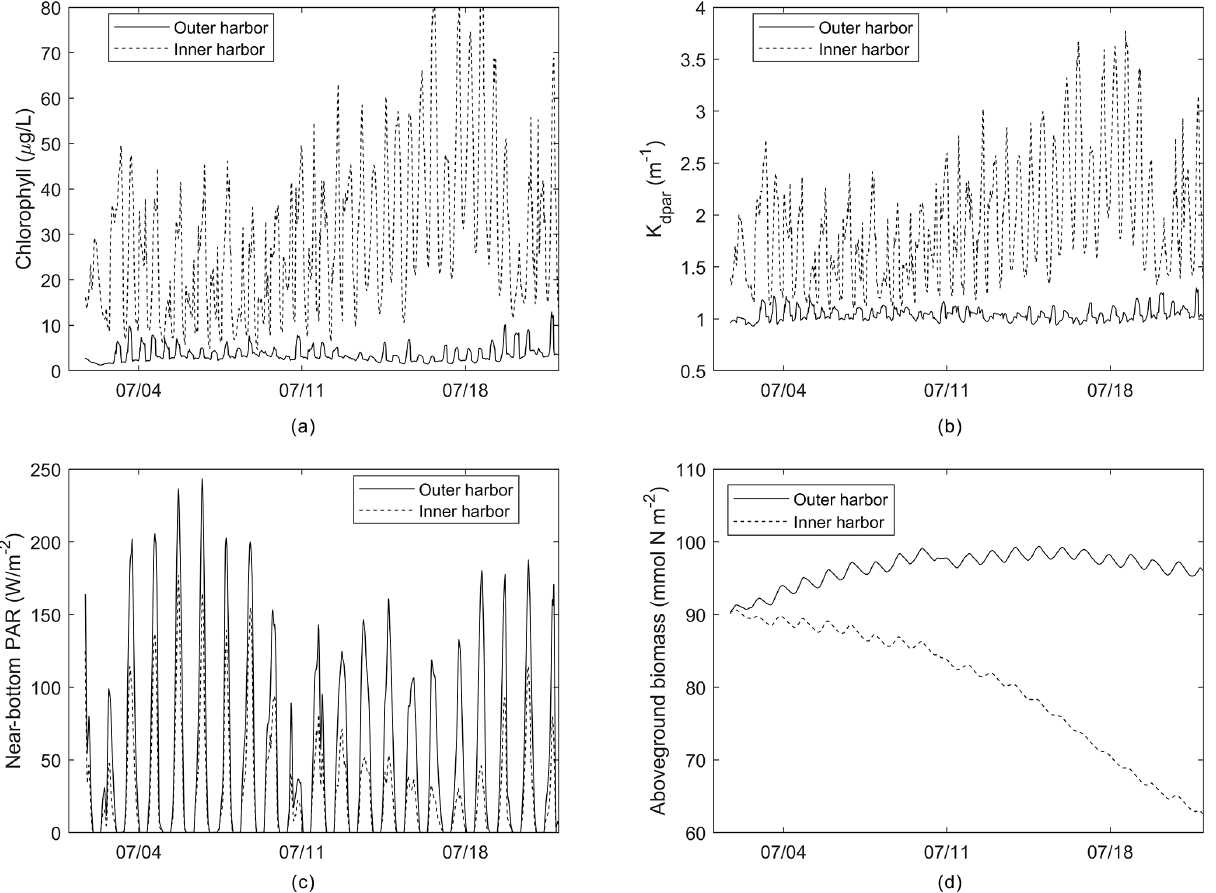
Figure 9. Time series of (a) chlorophyll, (b) light attenuation, (c) near-bottom PAR, and (d) aboveground biomass from outer and inner harbor locations identified in Fig.